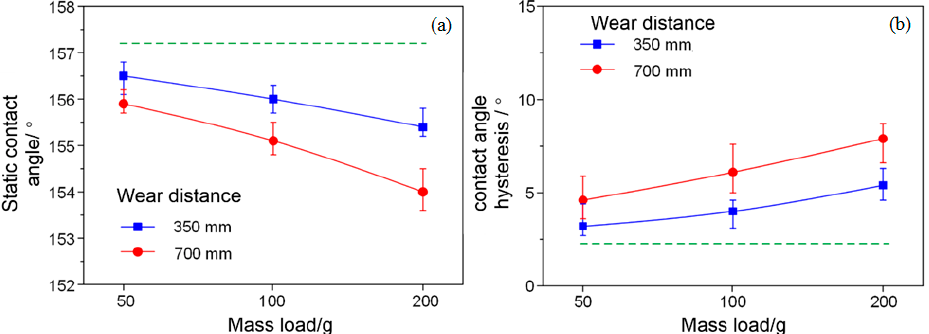
Figure 6. ( a ) Static water contact angles and ( b ) water contact angle hysteresis of the worn super- hydrophobic coatings.